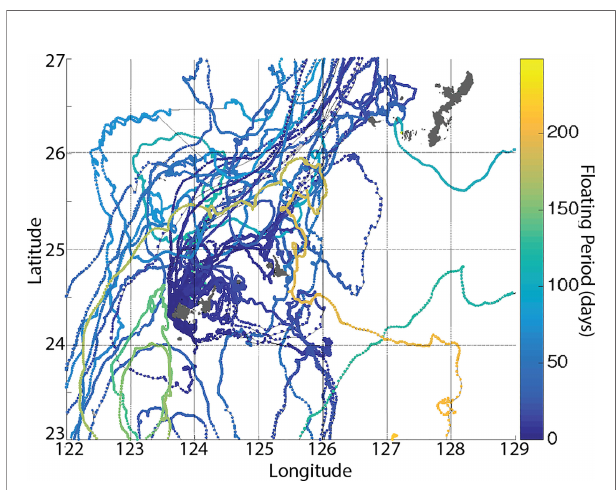
FIGURE 9 | The Ryukyu Archipelago, showing differences in concentration of trajectories within the island system, especially between west and east ends of the archipelago. Particles deployed from western Iriomote Island tend to stay on the west side of the archipelago, but showed frequent mixing within the Yaeyama region. The color bar shows temporal data in days for each position of the buoys.